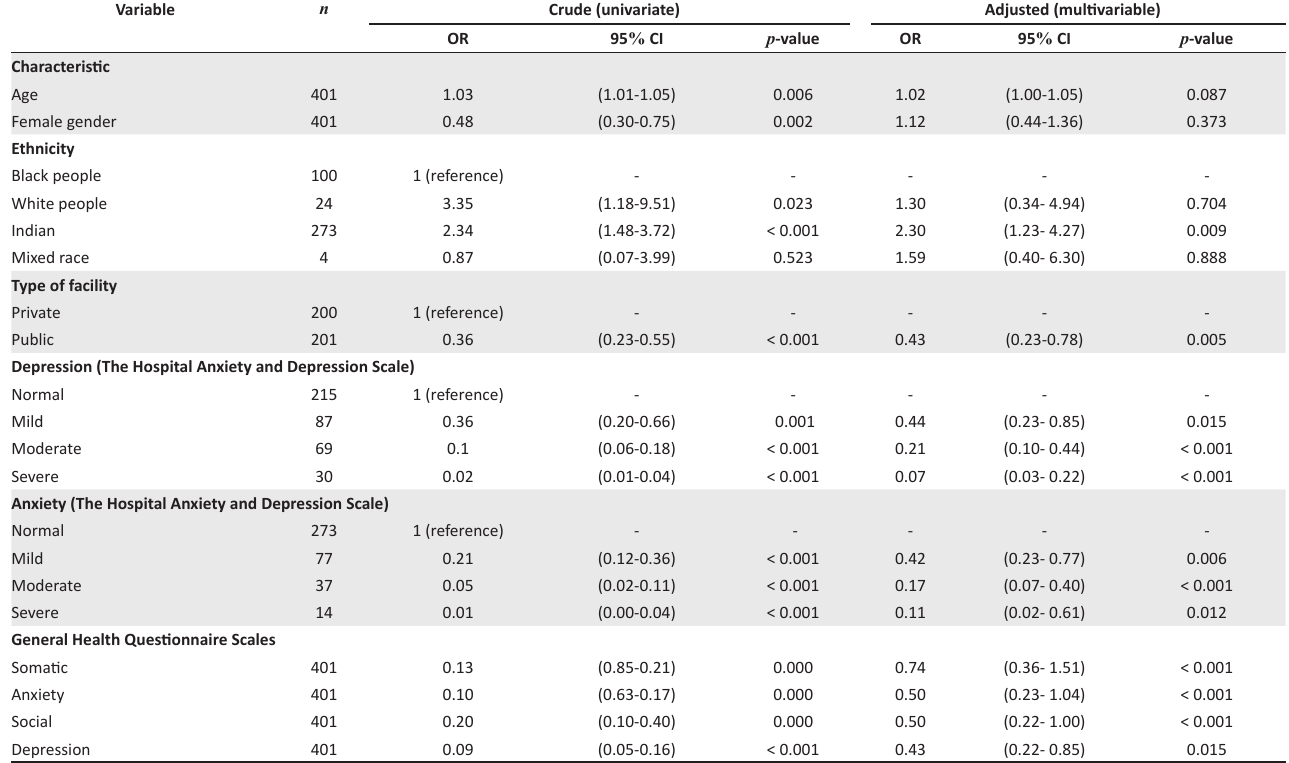
TABLE 6: Crude and adjusted analysis of factors affecting well-being.